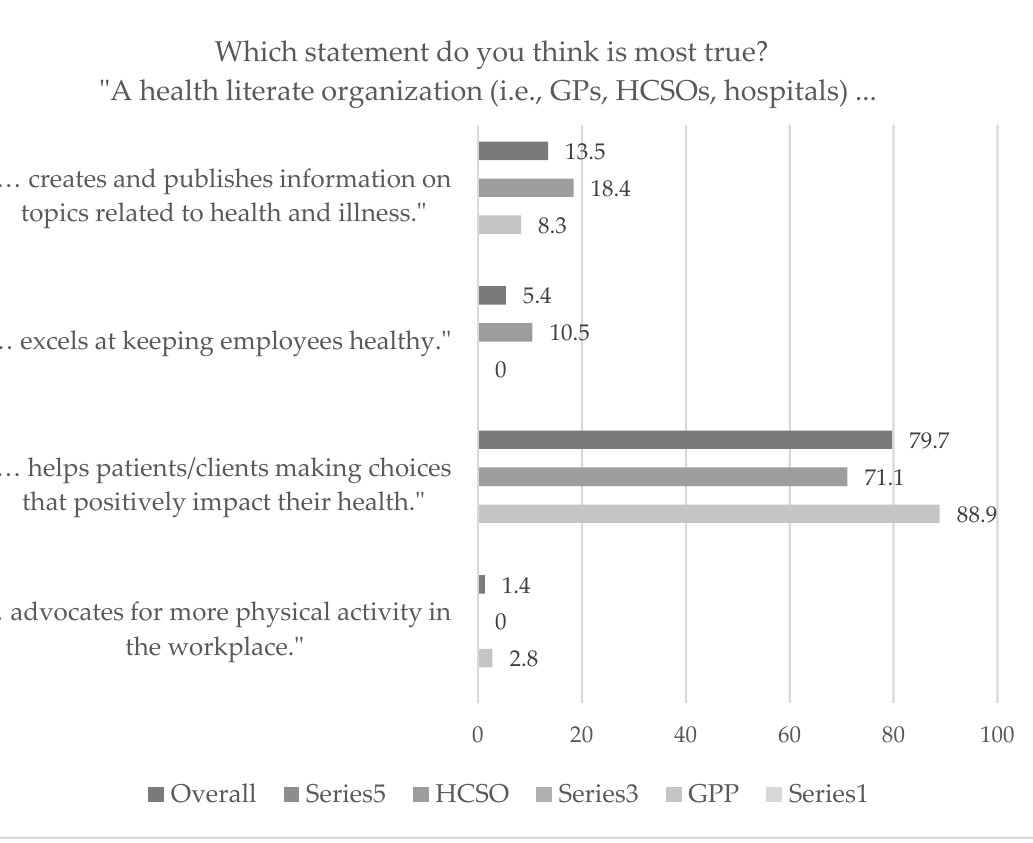
Figure 2. Primary care organizations’ understanding of the term health literate organization ( N = 74 overall, data in %). HCSO = home care service organization; GPP = general practitioners’ practice.